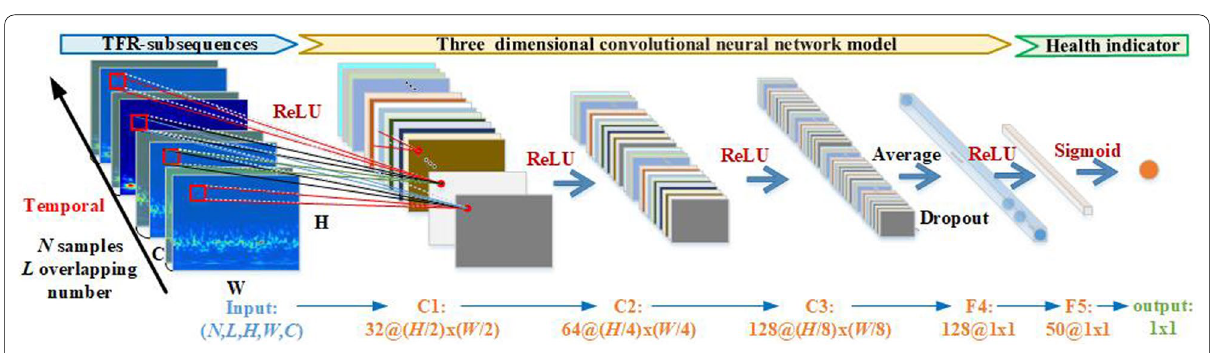
Figure 3 TFR-subsequence–3DCNN architecture for RUL estimation